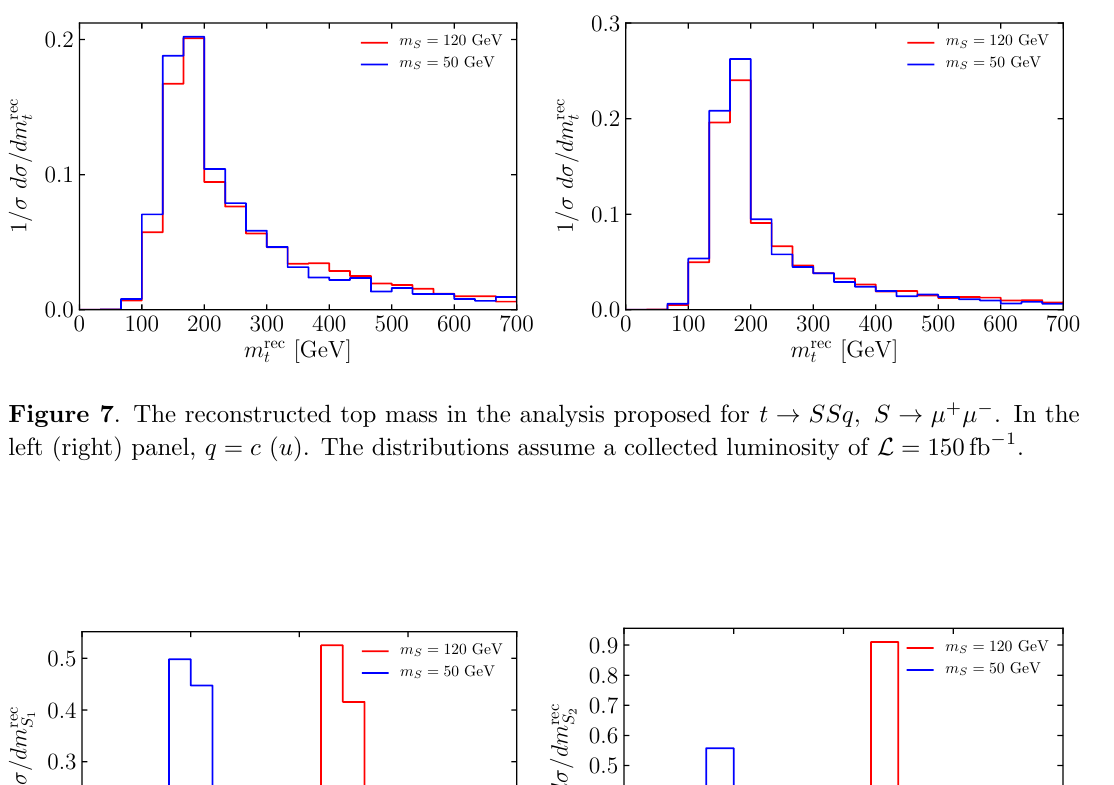
and m rec , in the analysis proposed for S 1 S 2